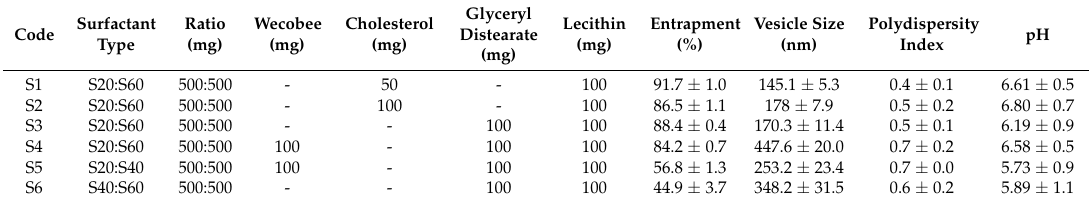
Table 1. Compositions, entrapment efficiencies (EE%) vesicle sizes with polydispersity index and pH of various proniosomal